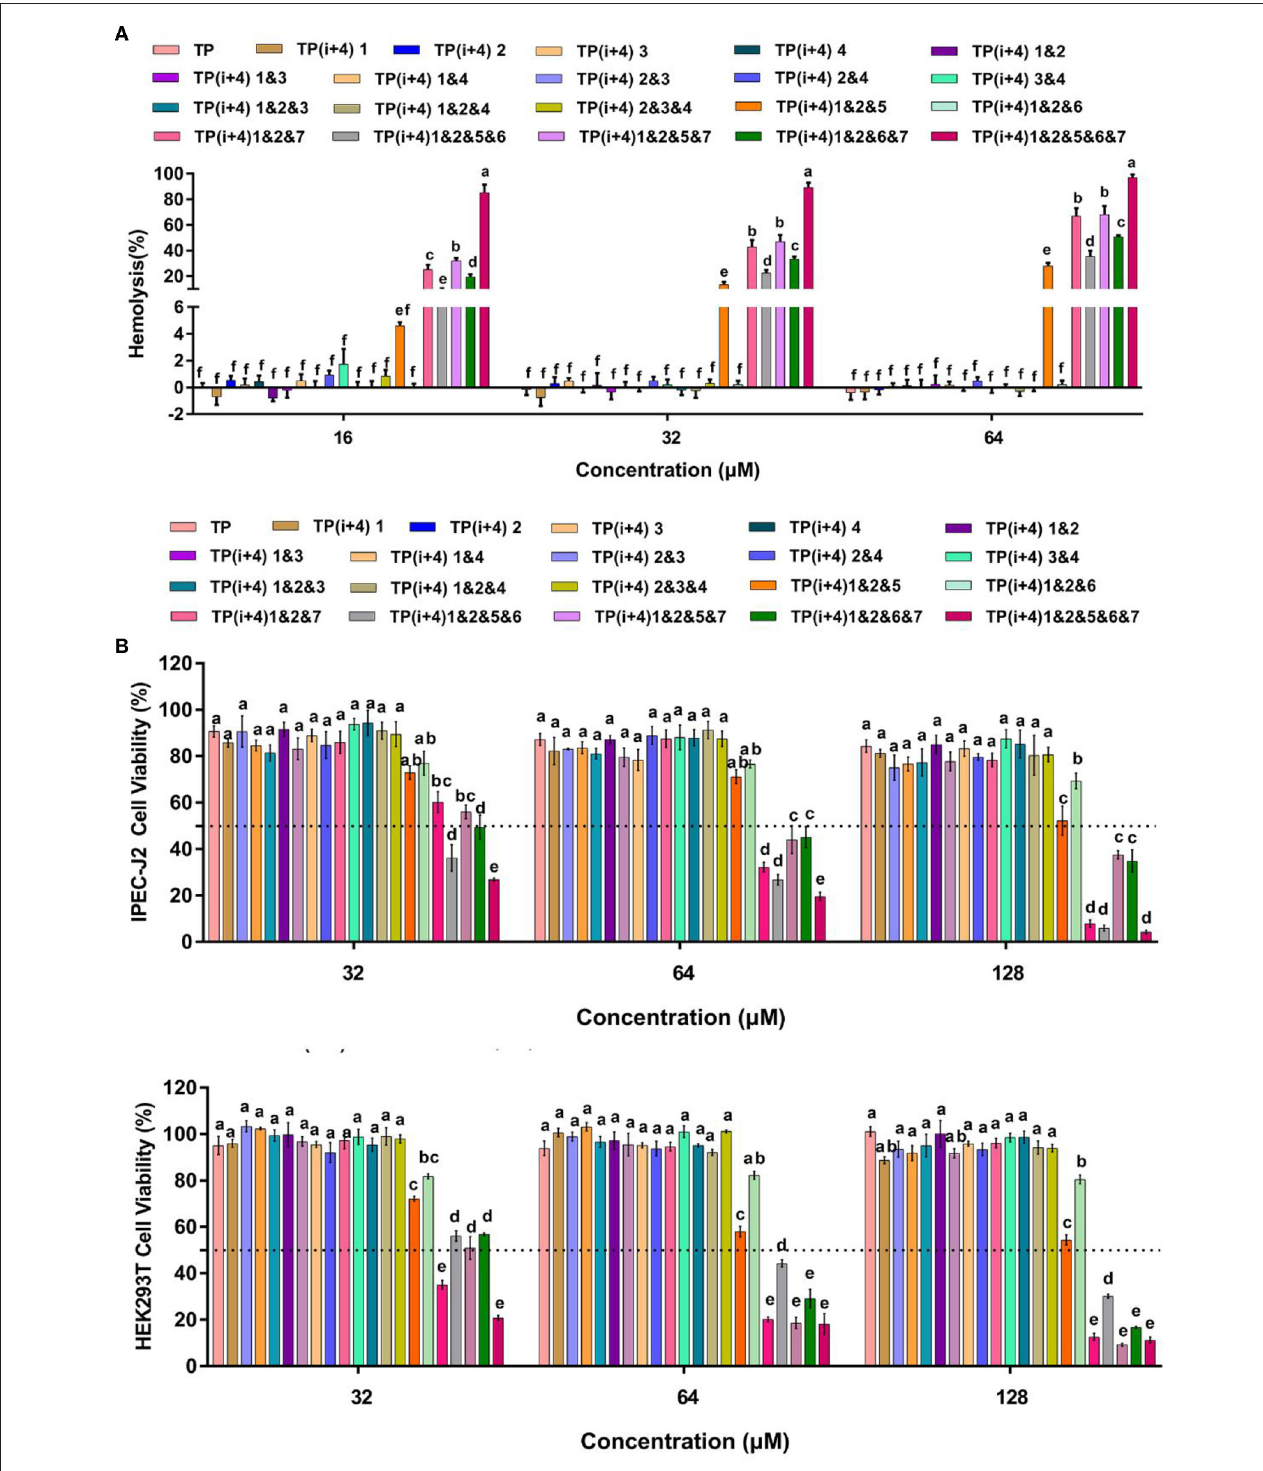
FIGURE 2 | (A) is the hemolytic activity of the designed peptides, (B) is the toxicity of the peptides designed for IPEC-J2 and HEK293T cells. A total of three independent tests were conducted for each test, and the data were expressed as mean ± SEM. Differences between groups at the same concentration were analyzed by one-way ANOVA. The values with different superscripts (a, b, c, d, e, f) indicate a significant difference ( p < 0.05).